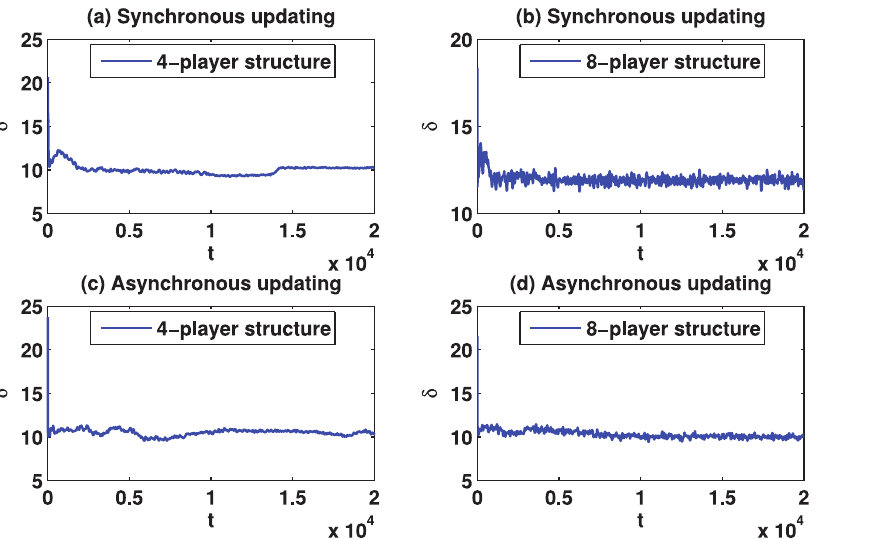
Figure 13. (Color online) Standard variance of the strategies d as a function of the evolution time on different square lattices under the Fermi rule given that R ~ 10 . (a) Results on the square lattice with 4-player neighborhood and synchronous updating; (b) Results on the square lattice with 8-player neighborhood and synchronous updating; (c) Results on the square lattice with 4-player neighborhood and asynchronous updating; (d) Results on the square lattice with 8-player neighborhood and asynchronous updating.